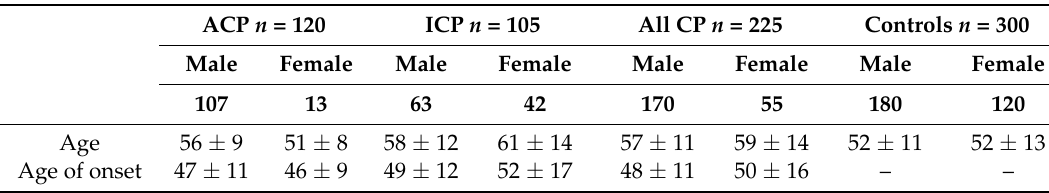
Table 7. Study population. Age represents age at recruitment. Mean ± S.D. are shown. CP: chronic pancreatitis. ACP n = 120 ICP n = 105 All CP n = 225